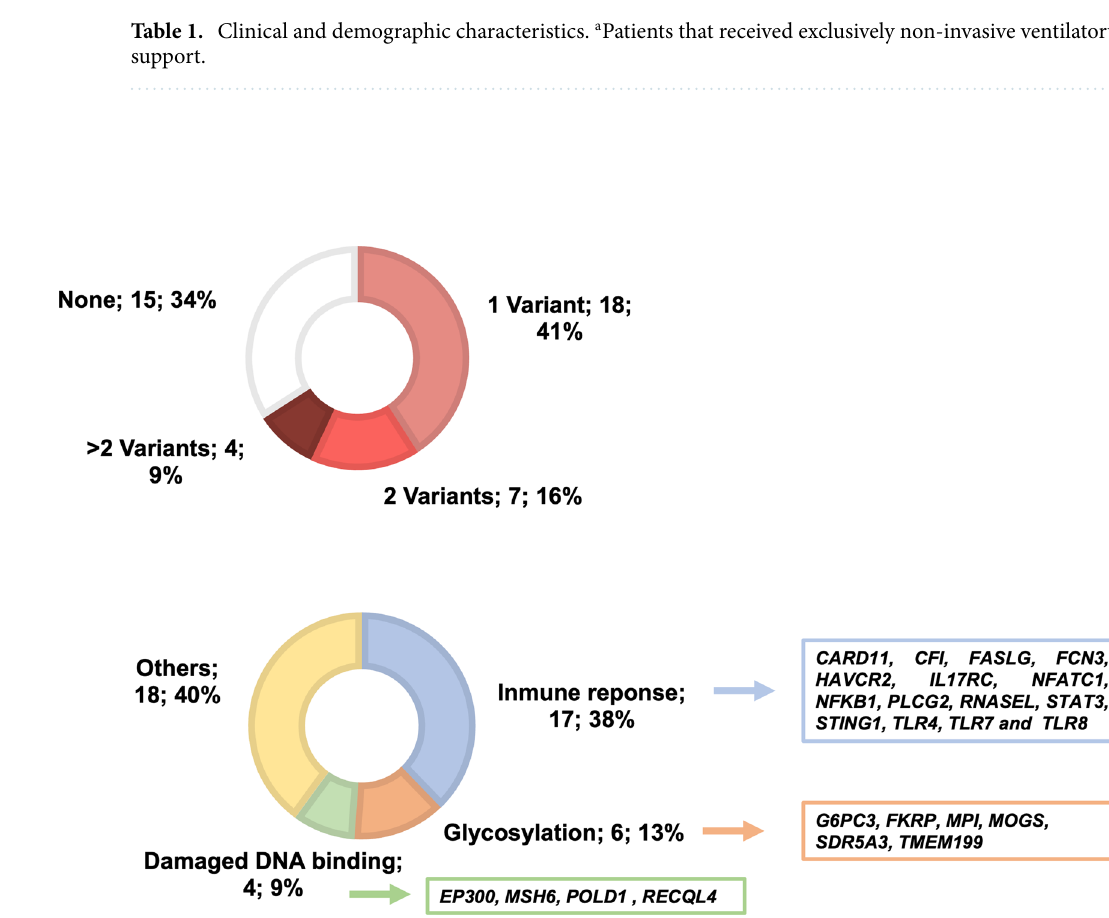
Figure 1. Identification of variants of interest in very severe COVID-19 patients: frequency and functional pathways involved. ( A ) Number and percentage of patients with none, one, two or more variants of interest, ( B ) Number and percentage of variants detected in each of the functional